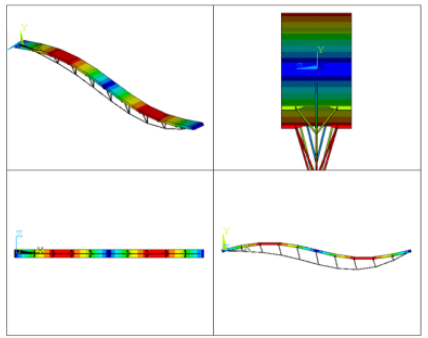
Figure 6. Antisymmetrical mode of vertical bending ( f a